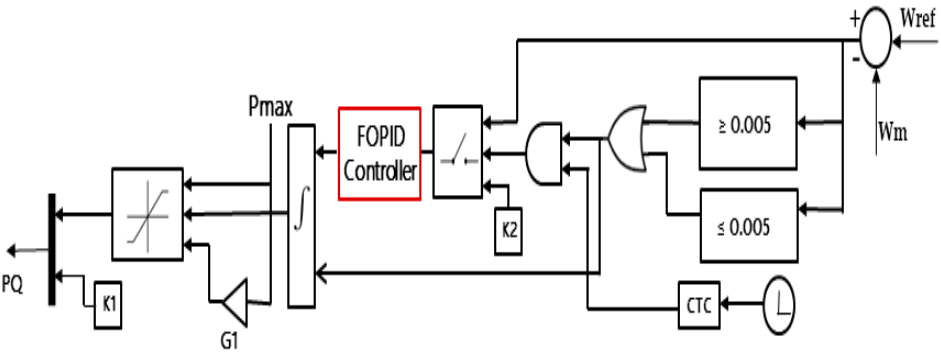
Figure 6. Proposed primary frequency controller.